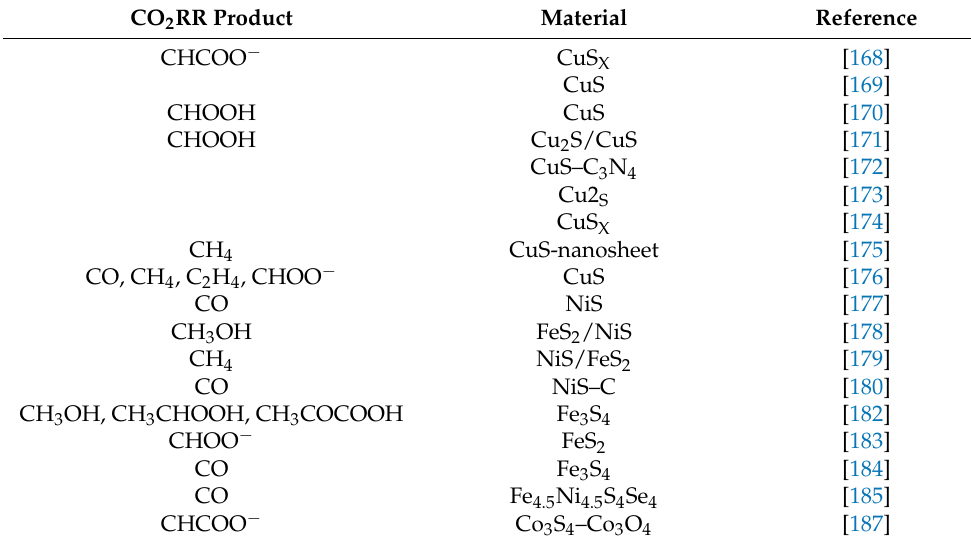
Table 2. Summary of products in the CO 2 RR using the various TMS from the first-row transition element nanomaterials and respective associated